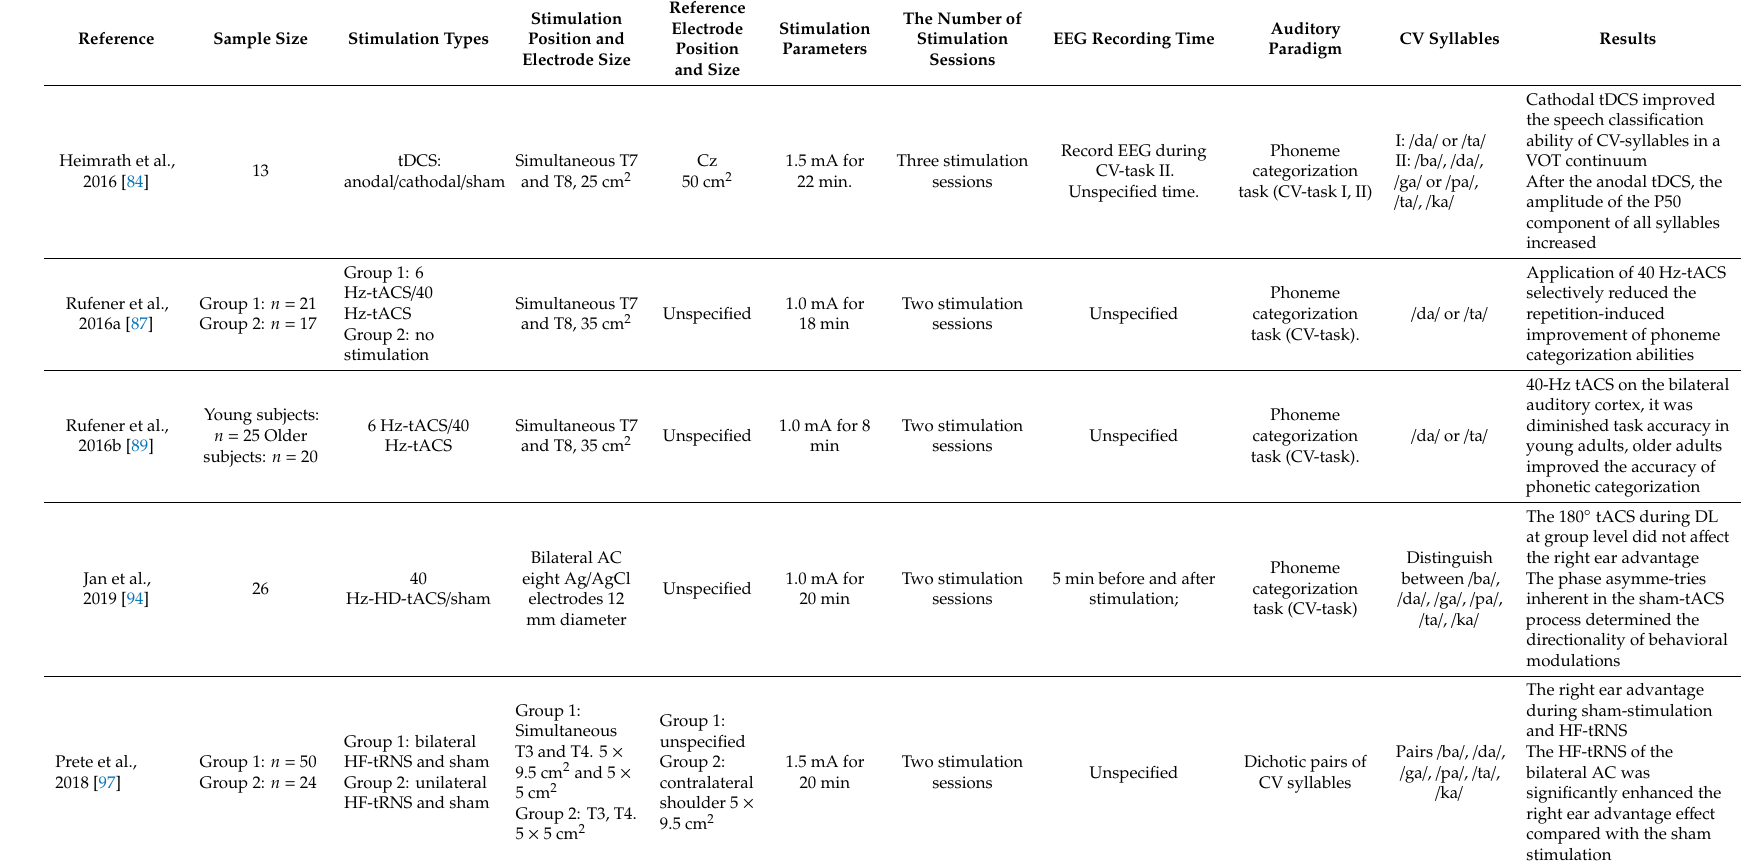
Table 3. Partial parameters, paradigm and results of tES e ff ects in syllables classification and right ear